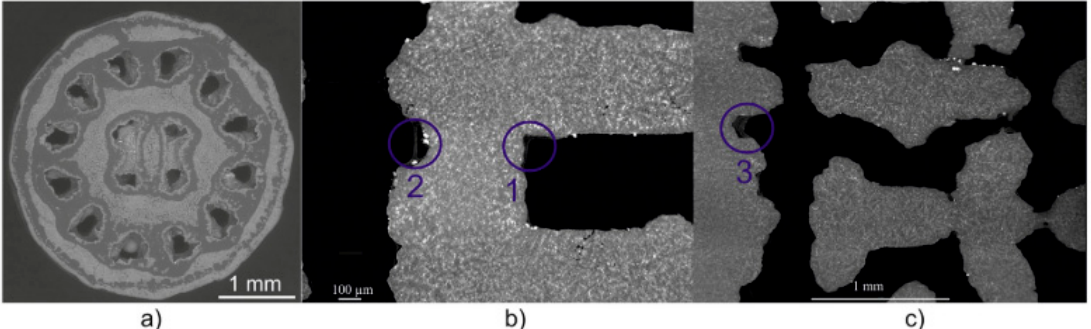
Figure 13. SEM image of the surface ( a ) and XRM images ( b ) and ( c ) of a cross-section of magnesium fluoride plus PLA coated implants, marked with three spots of visible PLA coated areas. Reprinted from Reference [99] with permission from Elsevier.